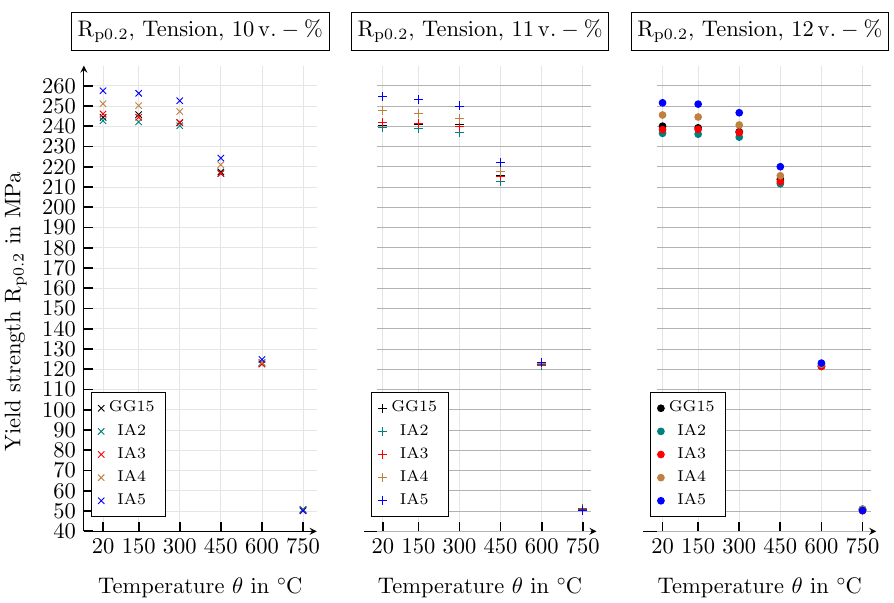
Figure 27. Yield strengths of all graphite classes with graphite flake volume fractions of 10, 11 and 12v. %, evaluated for the temperatures 20, 150, 300, 450, 600 and 750°C, at a tensile strain of −